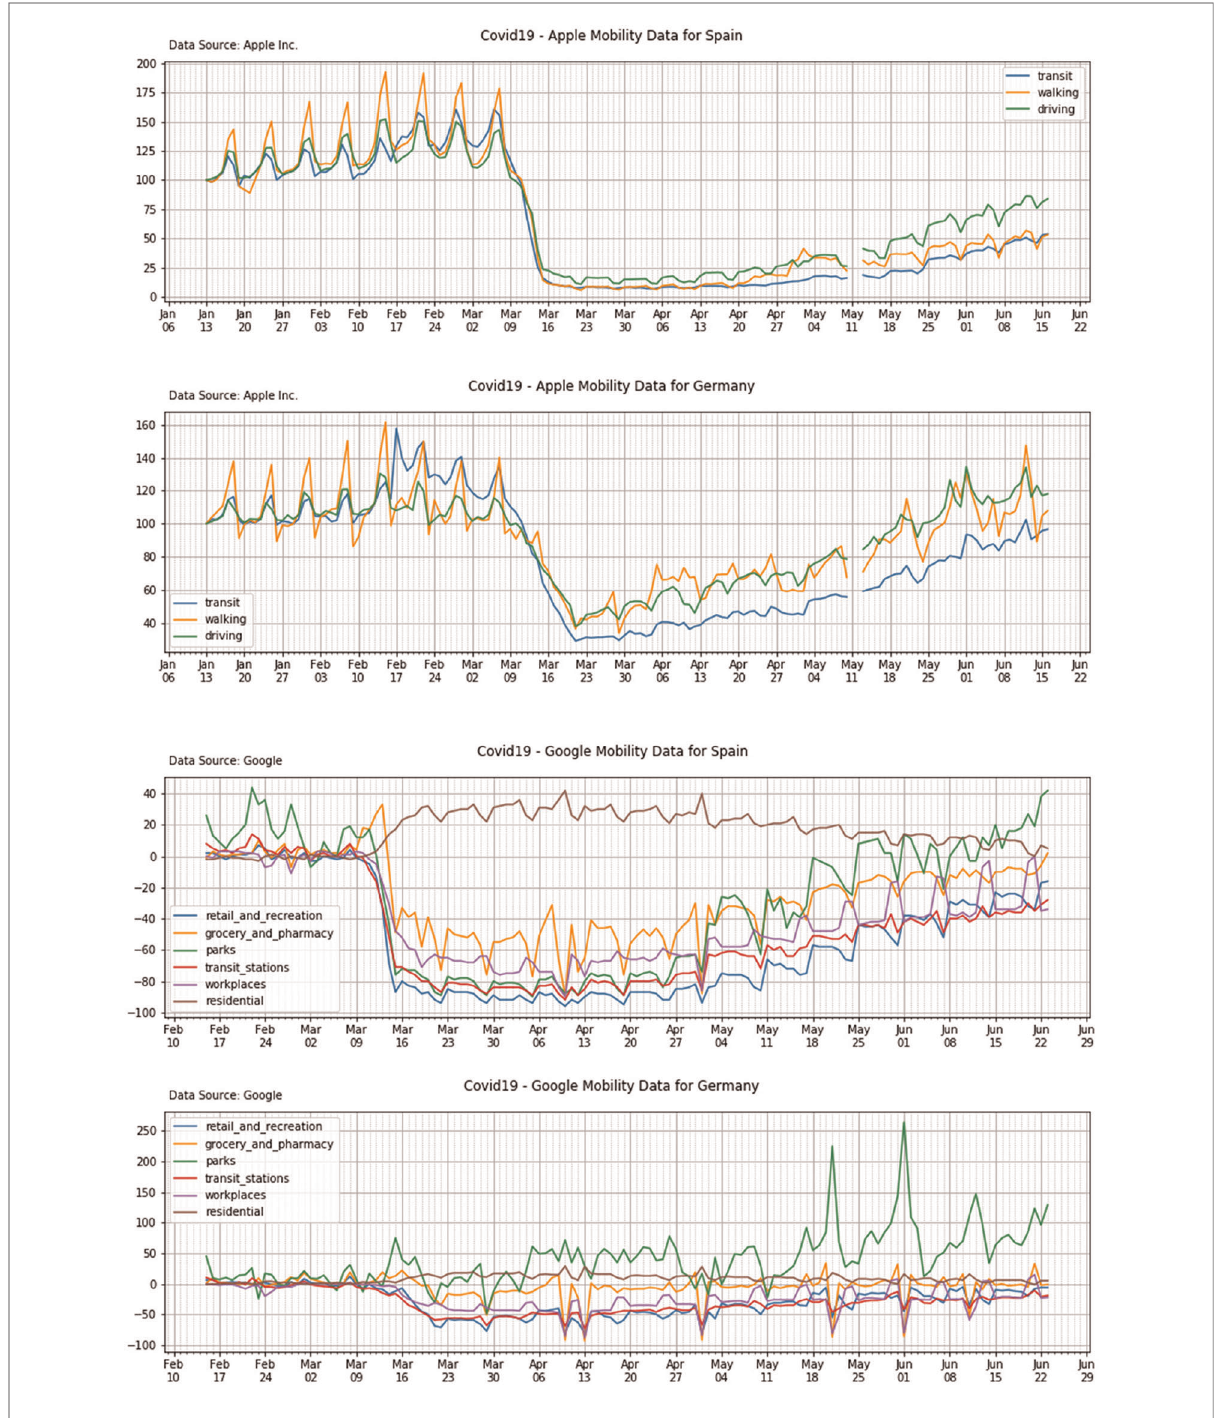
FIGURE 2 Apple mobility trends (top panels) and Google mobility trends (bottom panels) for Spain and